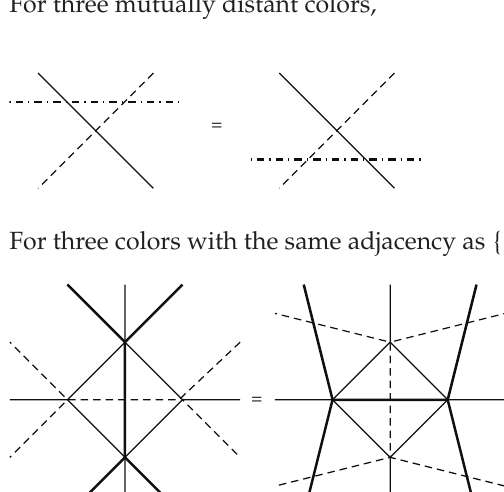
For three mutually distant colors,